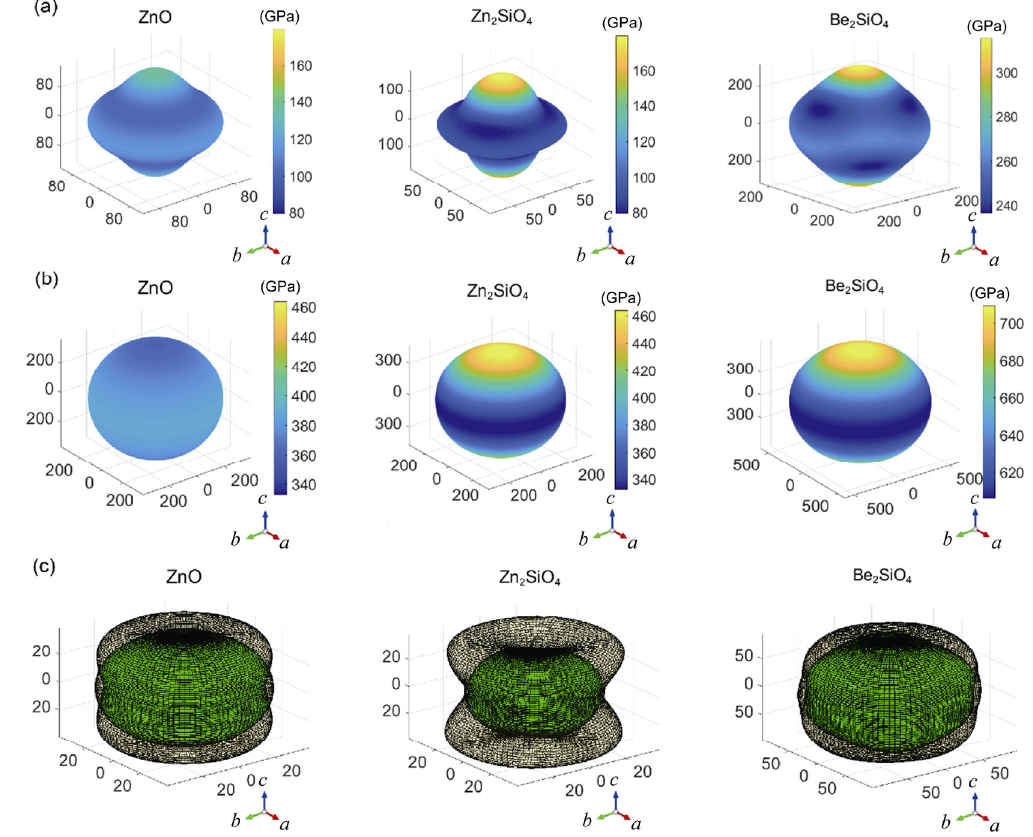
Fig. 5 Directional dependence of elastic properties in ZnO, Zn 2 SiO 4 , and Be 2 SiO 4 . (a) Young’s modulus, (b) reciprocal of linear compressibility, and (c) shear modulus in GPa (green surfaces and yellow surfaces represent the minimum and the maximum, respectively). For Be 2 SiO 4 , the elastic constants are adopted from Ref.